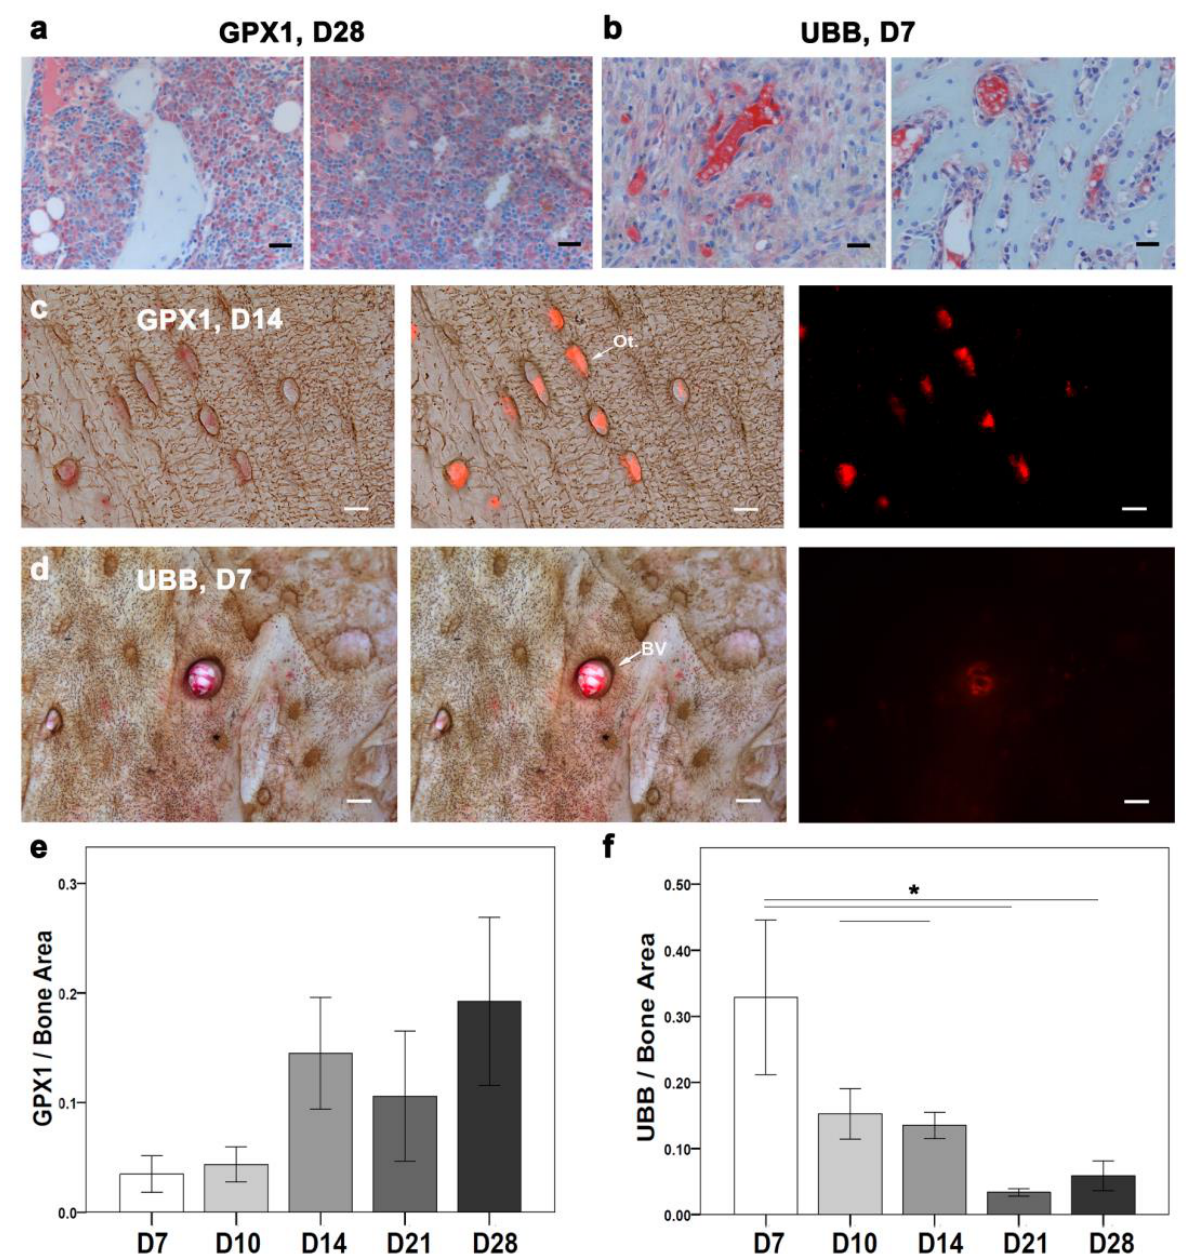
Figure 7. Temporally contrasting regulation of mitochondrial and ribosomal genes reflected on signal intensity and localization of GPX1 and UBB proteins through healing progression. ( a ) Mitochondrial marker GPX1 signal was abundant at D28 and localized around the cells in the newly formed bone and within the bone marrow. ( b ) Ribosomal Marker UBB signal was aberrant at D7 and localized in cells at the periosteal region and within bone marrow cells. ( c ) GPX1-positive signal was detected within active osteocytes. ( d ) UBB-positive signal was visualized around blood vessels in the fractured callus; however, none was seen within the osteocyte or their vicinity. ( e ) GPX1-positive signal portion was highest at D28. ( f ) UBB-positive signal portion was significantly higher at D7, D10, and D14n compared with D21. (Ot: osteocytes; N: D7 = 4, D10 = 6, D14 = 3, D21, D28 = 5; nonparametric distribution with Mann-Whitney U-test; * ≤ p = 0.05; scale bar: ( a , b ) (25 µ m), ( c , d ) (5 µm).